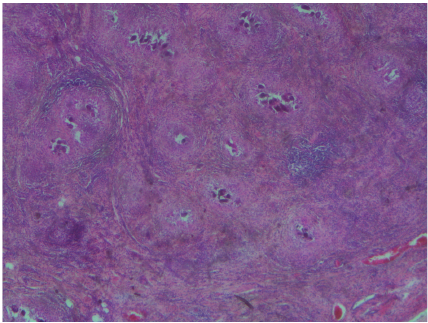
Figure 1: H and E stain showing chronic granulomatous inflamma- tion in tunica with schistosoma eggs ( × 2).